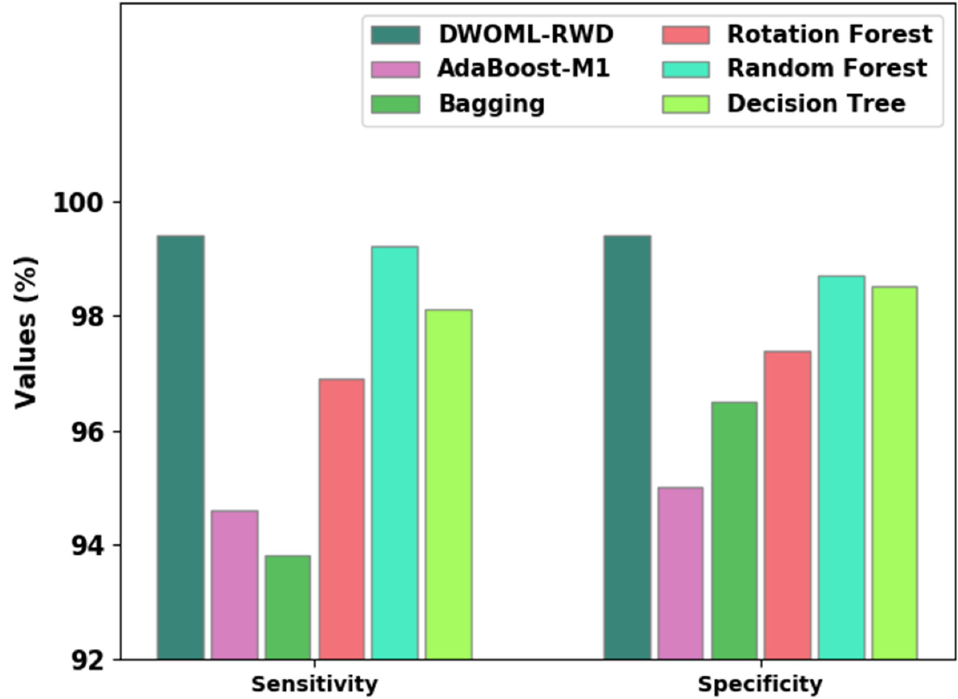
Figure 11. FNR and FPR analysis of DWOML-RWD approach with existing Figure 10. 𝑆𝑒𝑛𝑠 (cid:3052) and 𝑆𝑝𝑒𝑐 (cid:3052) analysis of DWOML-RWD approach with existing algorithms. Based